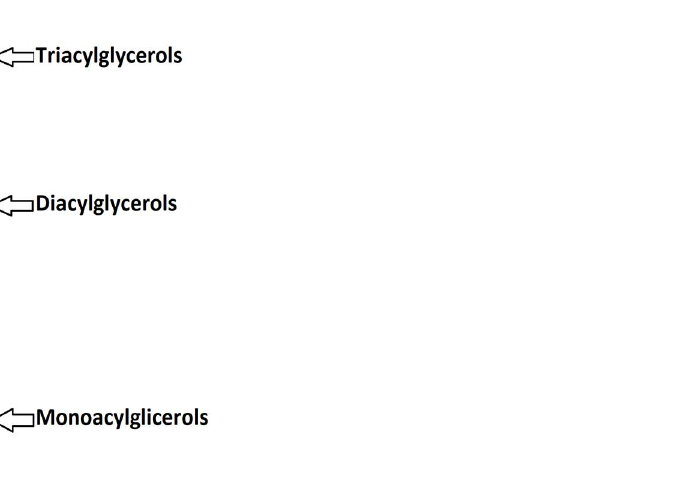
Figure 2. Analysis of monoacylglycerols (MG), diacylglycerols (DG) and triacylglycerols (TG) of purified sAG synthesis by thin-layer chromatography separation. Results obtained by enzymatic intra–interesterification by fractionation under CO 2 SC conditions of sAG are shown in different lanes: E. 1 (Extraction or fraction 1), E. 2 (Extraction or fraction 2) and E. 3 (Extraction or fraction 3).